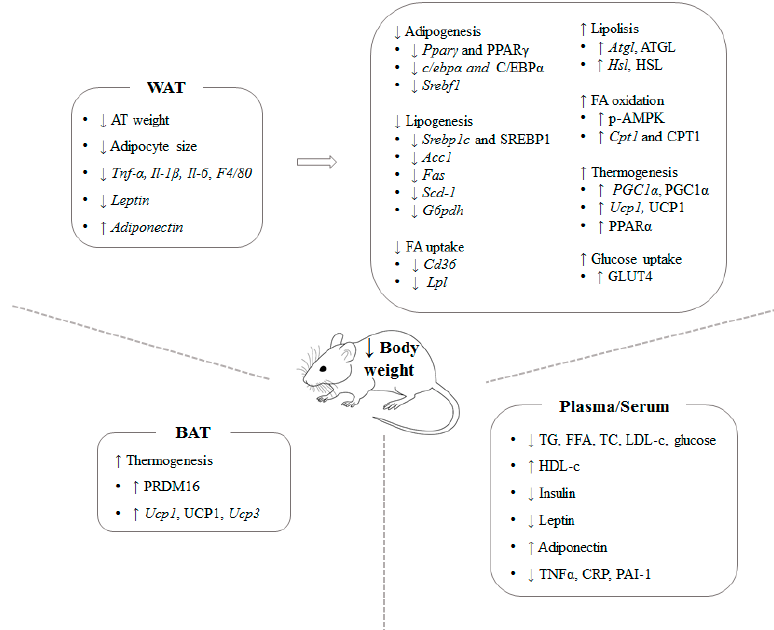
Figure 2. Anti-obesity effects and mechanisms of action described in in vivo studies. ACC: Acetyl-CoA carboxylase, AT: adipose tissue, ATGL: adipose triglyceride lipase, BAT: brown adipose tissue, Cd36: cluster of differentiation 36, C/EBP α : CCAAT-enhancer-binding protein α , CPT1: carnitine palmitoyltransferase 1, CRP: C reactive protein, F4/80: homologue in mouse to epidermal growth